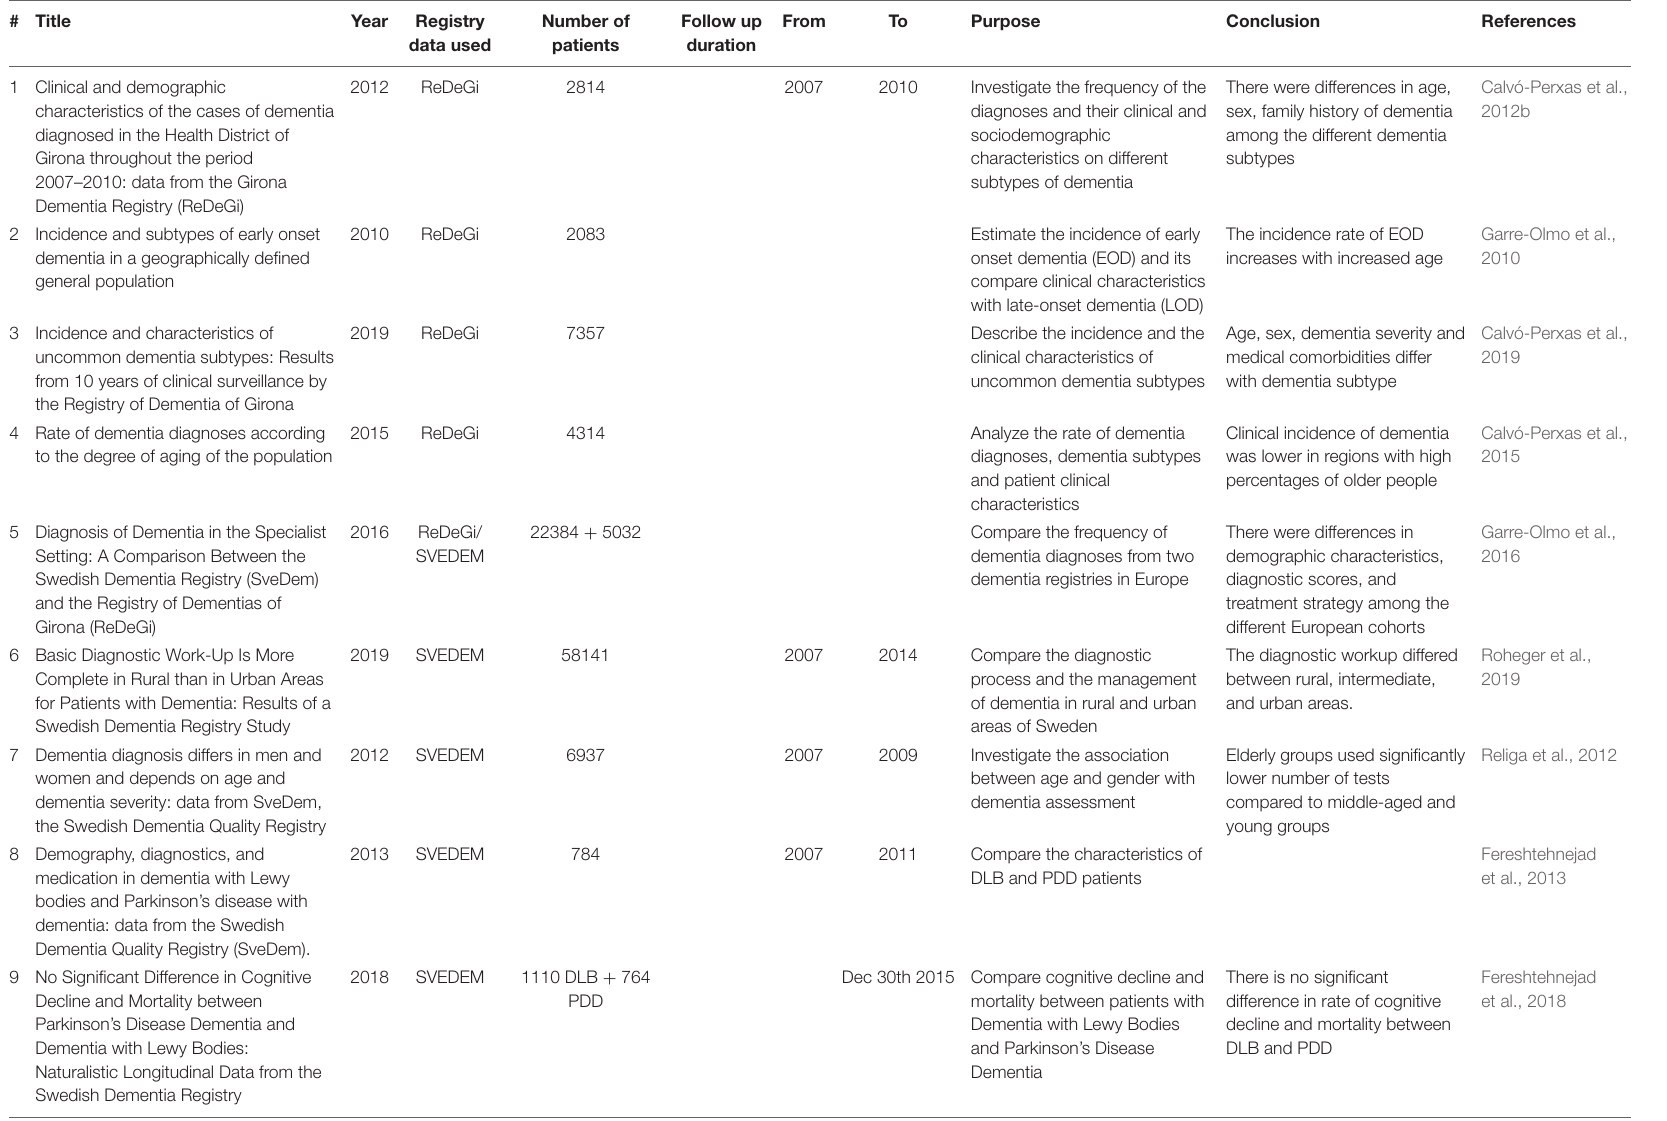
TABLE 1 | Registry-based studies on dementia incidence and patients’